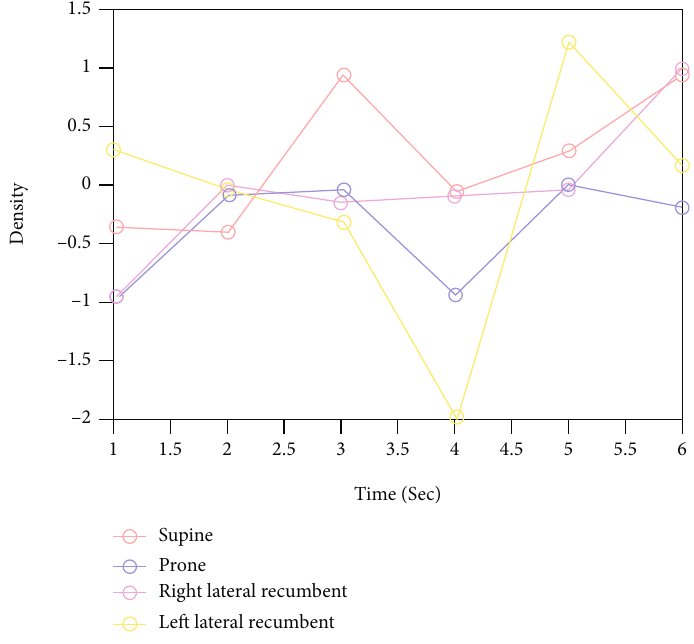
Figure 8: Sleep posture prediction rate. Table 1: Comparative chart of sleep posture